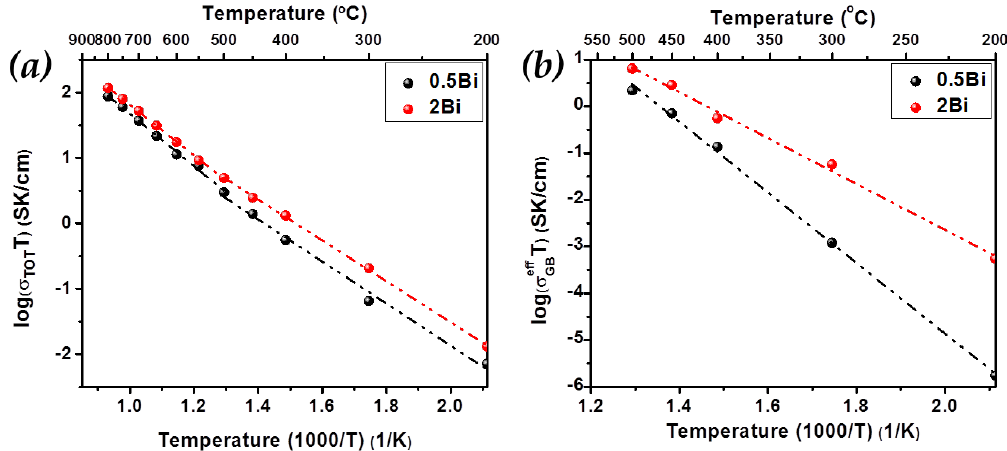
Figure 6. Arrhenius plots from EIS spectra of the sintered samples: ( a ) total conductivity (800 – 200 °C); ( b ) grain boundary conductivity (500 – 200 °C).